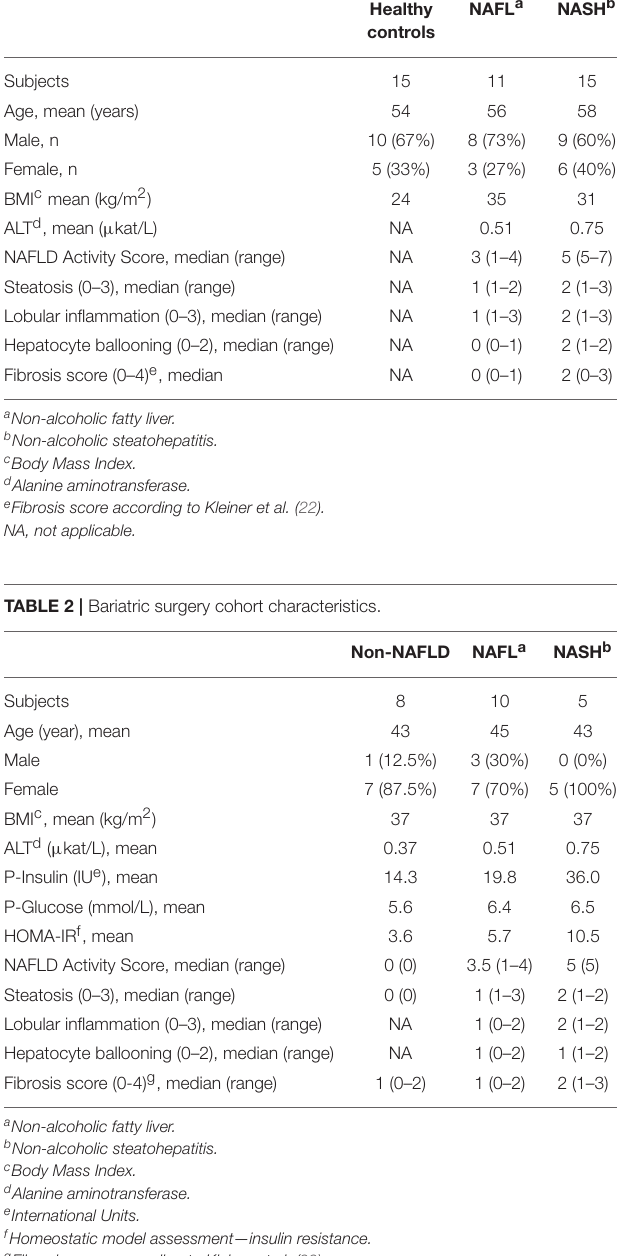
TABLE 1 | NAFLD cohort characteristics.